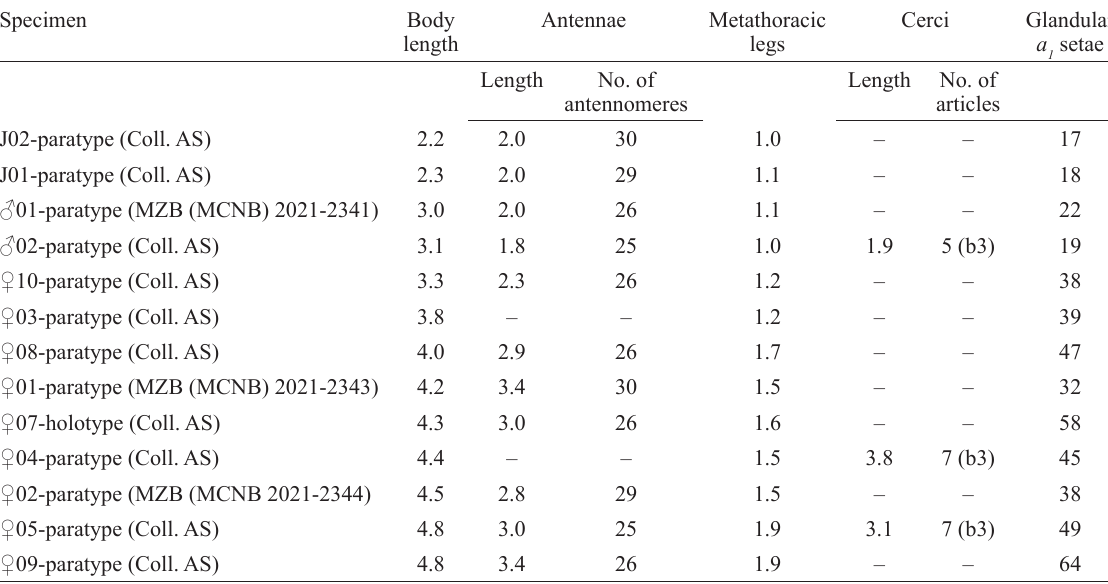
Table 1. Turkmenocampa edaphica Sendra & Sánchez-García sp. nov., length of body, antennae, metathoracic legs, and cerci (measured in mm); and number of antennomeres, cercal articles, and number of glandular a setae on the first urosternite 1